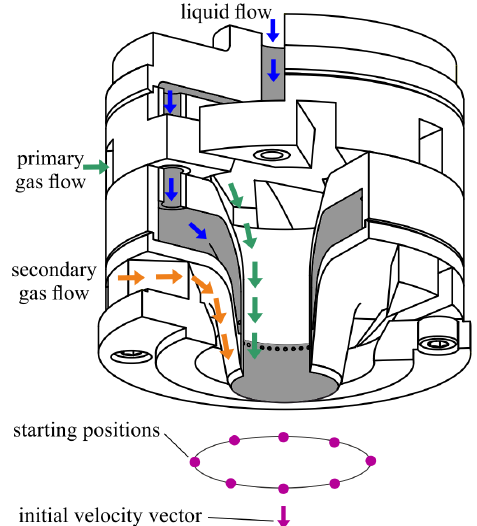
Figure 1. Sketch of annular prefilming airblast nozzle illustrating common droplet starting positions and initial velocity vector in magenta, adapted from